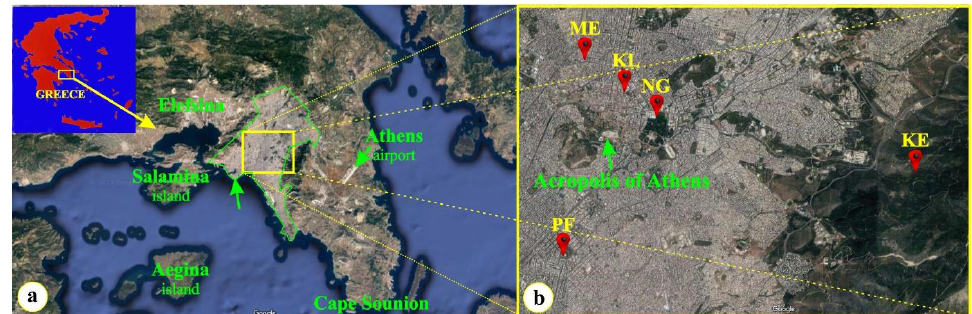
Figure 1. Cross-sectioned leaflets of fully expanded compound leaves from the selected trees. All sections were stained with toluidine blue “ O ” . ( a ) Leaf cross-section from the suburban site (KE), where the main histological features are indicated. ( b ) Leaf cross-section from the urban site PF, with the compact adaxial epidermis and the heavy load of phenolics within its cells. ( c ) Leaf cross- section from the urban site ME; the broken material out of and over the adaxial epidermis is con- densed tannins. ( d ) Leaf cross-section from the urban site KL. ( e ) Leaf cross-section from the urban site NG that appears to have originated from a more xeromorphic plant as indicated by the heavier accumulation of phenolics within the mesophyll and the epidermal cells.